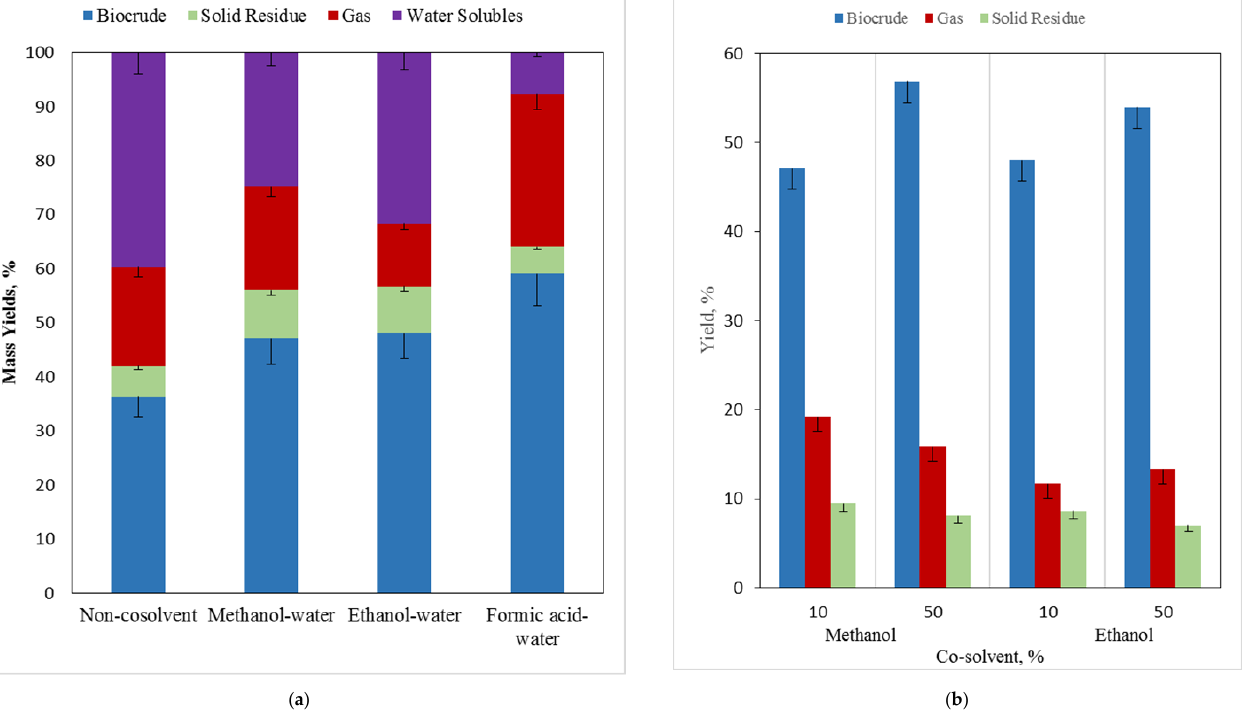
Figure 2. Co-solvent HTL of S. platensis: ( a ) effect of solvent types on product mass distribution in different solvents (at 1:10 co-solvent to water ratio), ( b ) effect of co-solvent amounts (%) on yields of biocrude, gas, and solids. (HTL experiments were conducted at 300 °C, 30 min time, and 20% solids loads).